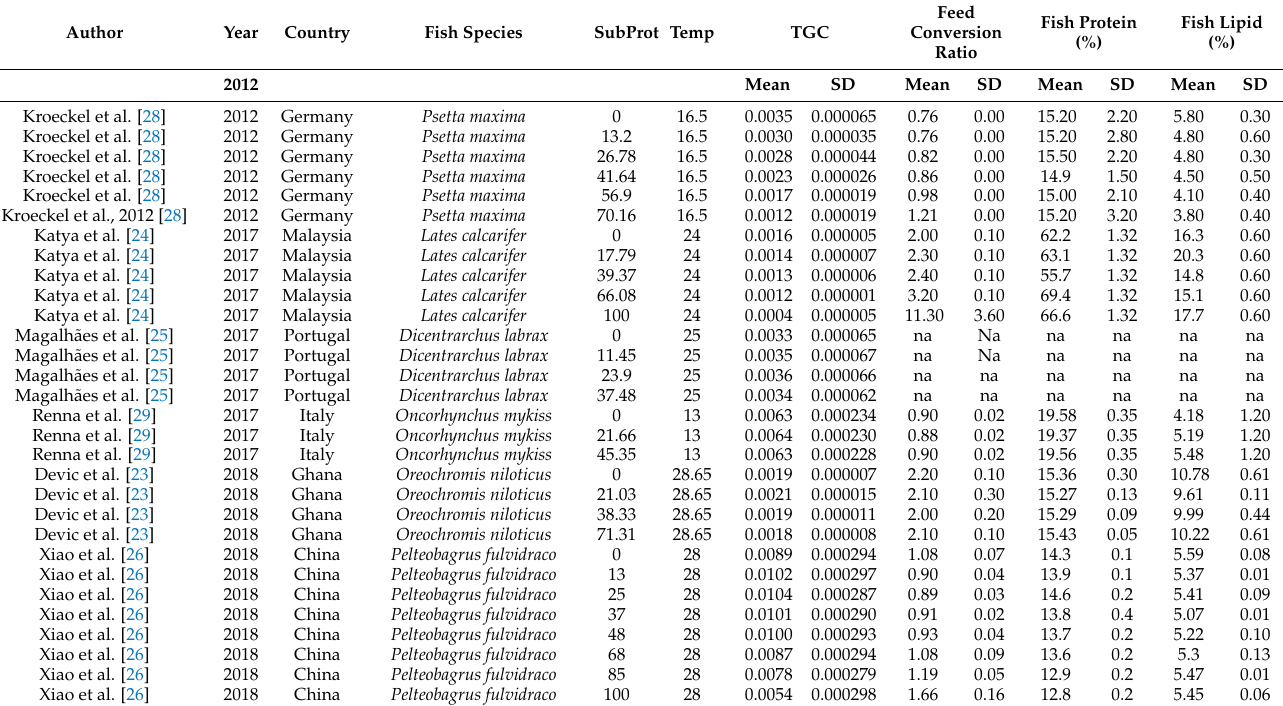
Table A1. Full list of studies used for the meta-analysis; na = missing